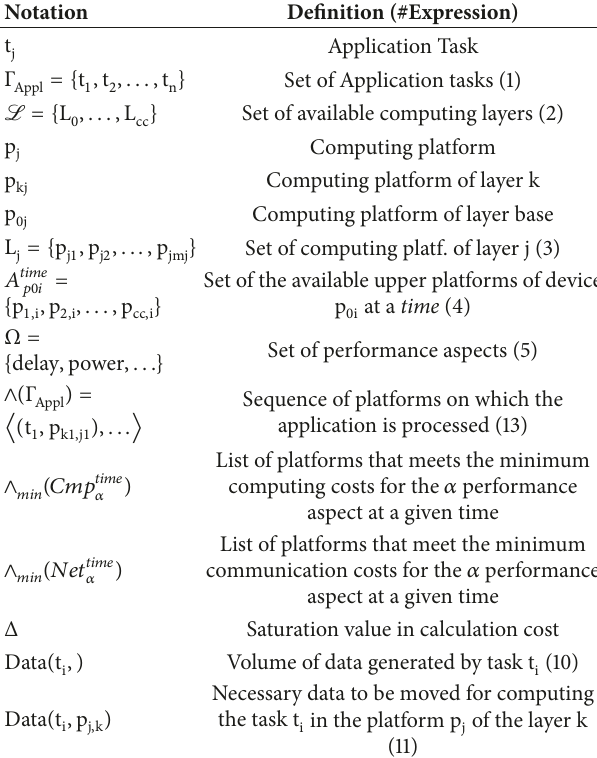
Table 3: Summary of Notations. Table 4: Summary of